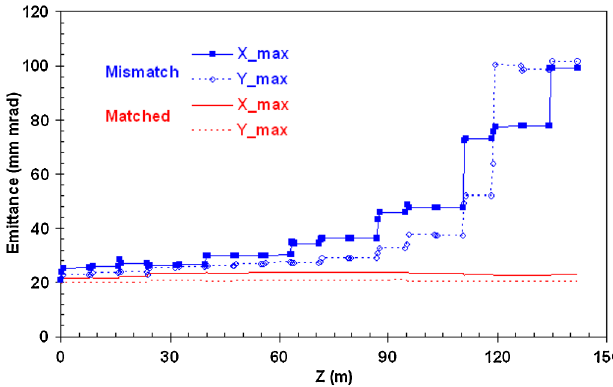
FIG. 3. (Color) Maximum beam emittance dilutions for matched and mismatched beams in an 18-cell doublet lattice with all the doublets made up of identical